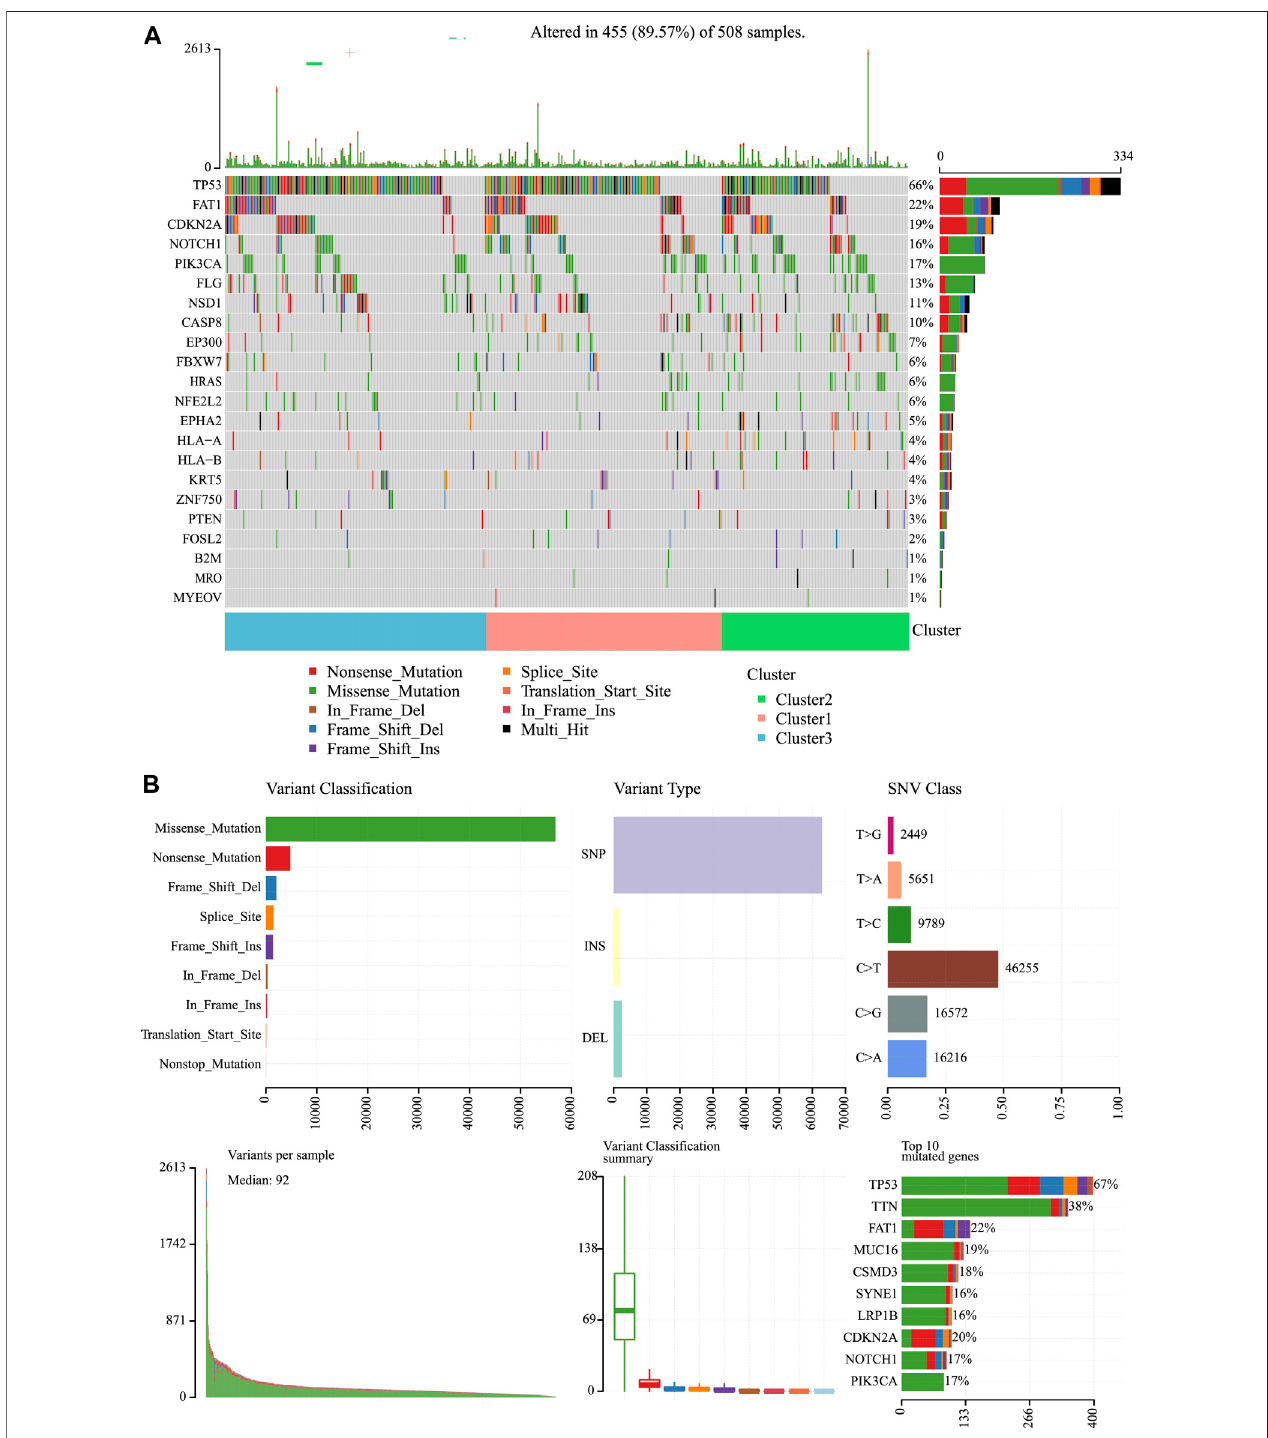
FIGURE 6 | Mutation analysis for the three subtypes of HNSCC. (A) Somatic landscape of HNSCC cohort. (B) Distribution of the gene with a higher mutation frequency in different mutation types and the change of nucleotide sites.